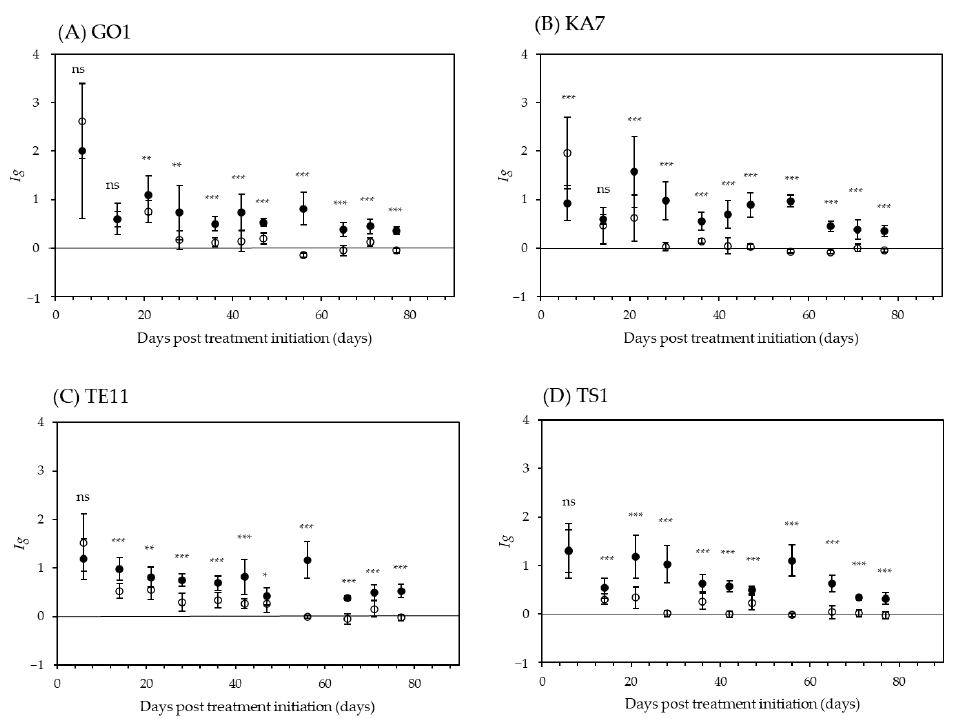
Figure 2. Changes in the stomatal conductance index ( Ig ) in the four clones. ( A – D ) show the results obtained for GO1, KA7, TE11, and TS1, respectively. Open and closed circles denote the drought and control treatments. Statistically significant differences in the Ig between treatments at each day post-treatment (dpt) for each clone were evaluated by Student’s t -test (ns: not significant, *: p < 0.1, **: p < 0.05, and ***: p < 0.01).